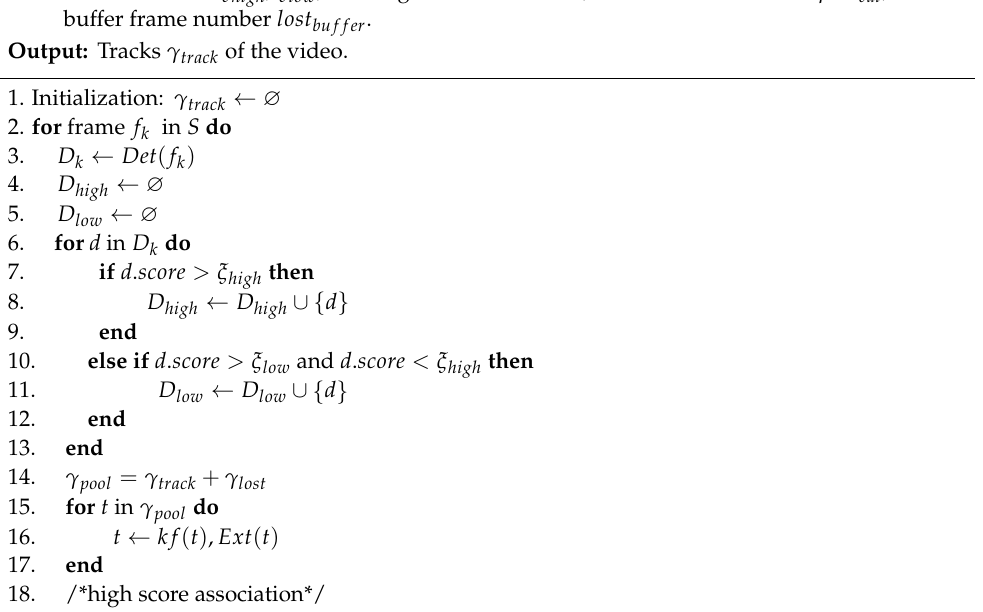
Algorithm 2: Pseudocode of data association